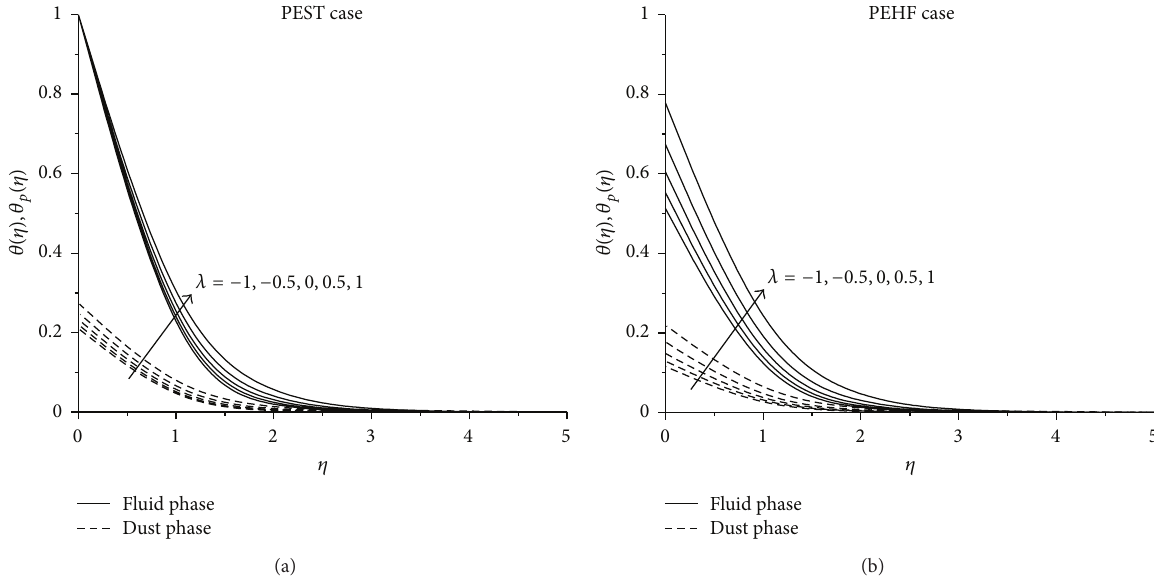
Figure 5: Effect of 𝜆 on temperature profiles for both PEST and PEHF cases with 𝑁 = Ec = 𝑆 = 0.5 , Pr = 0.72 , and 𝛽 = 0.6 .